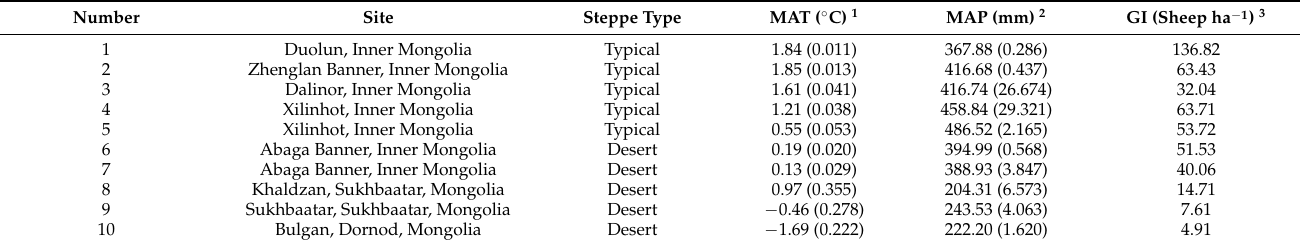
Table 1. Environmental characteristics at the study